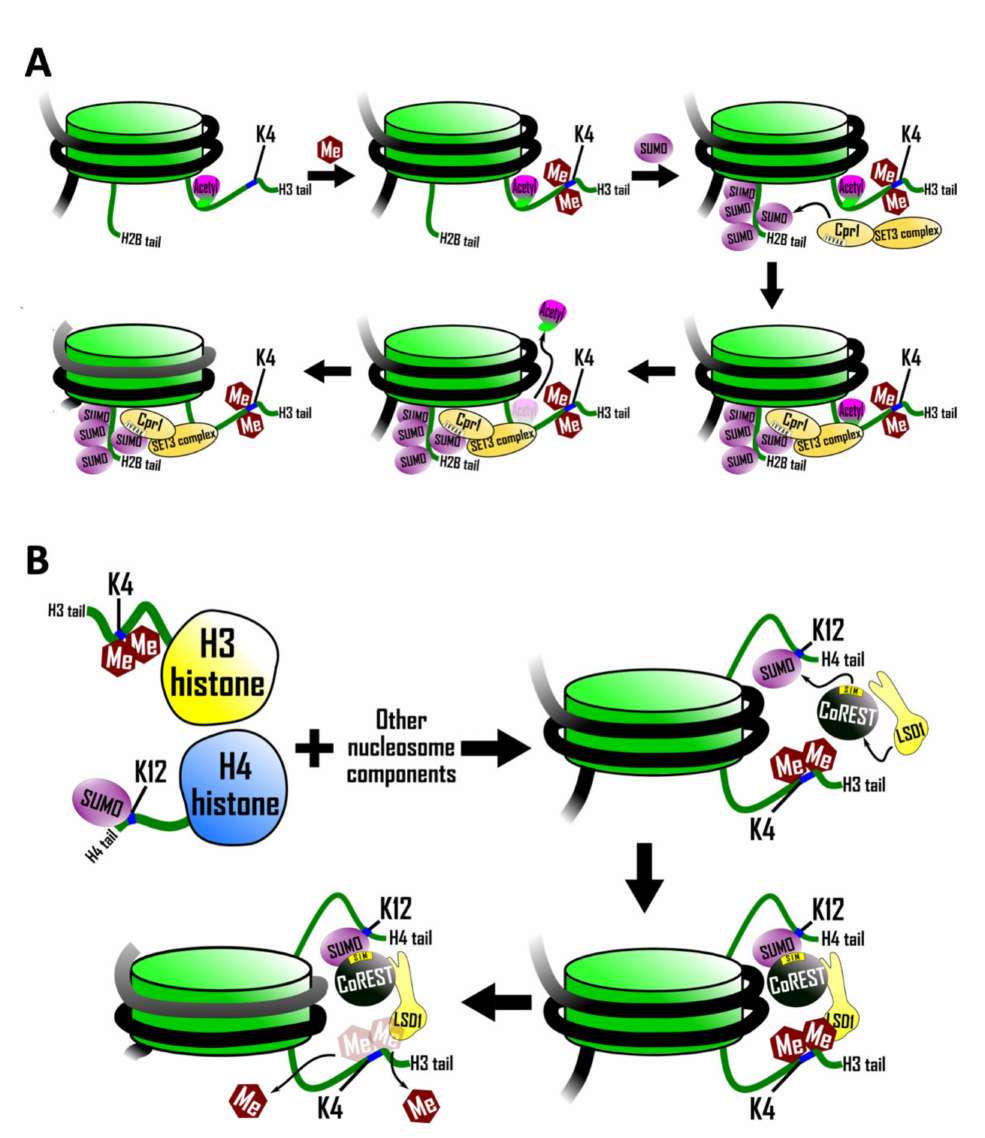
Figure 2. Regulation of histone modification by SUMO/SIM interactions. ( A ) Histone H3 is dimethy- lated on K4 (by Set1). Dimethlyated H3 histone then promotes the SUMOylation of histone H2B. Next, SUMOylated histone H2B recruits the Set3 histone deacetylase complex (HDAC) by interaction with a SIM in Cpr1, a subunit in the Set3 complex. Finally, Set3 removes acetyl groups from H3 to repress transcription. ( B ) K4-dimethylated histone H3 and K12-SUMOylated H4 are combined with DNA to form nucleosomes in vitro. Nucleosomes are then incubated with CoREST and LSD1. LSD1 and CoREST are only able to increase the rate of de-methylation of histone H3 K4 when the SIM on CoREST is